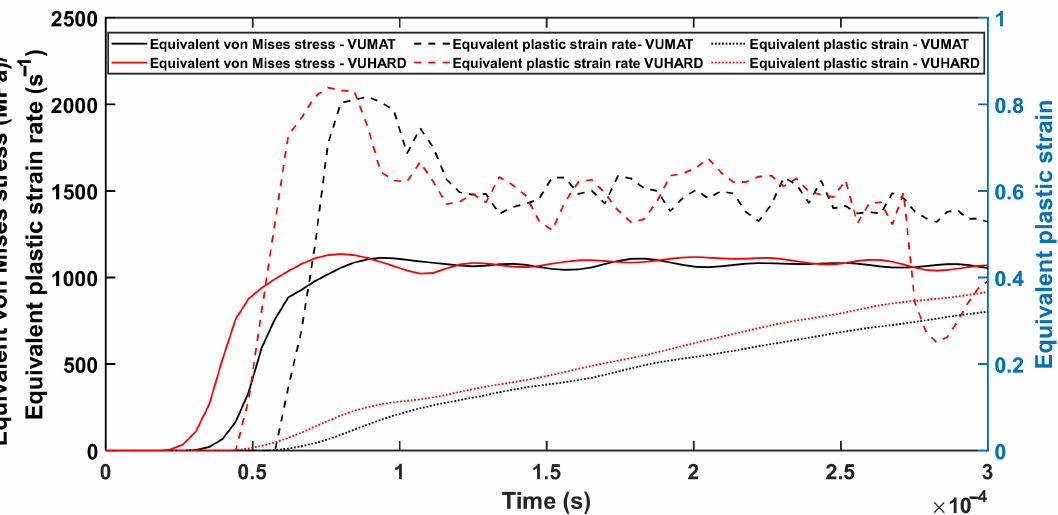
Figure 7. The equivalent von Mises stress, plastic strain and plastic strain rate against time generated during the simulation of the SHPB test using the VUMAT and VUHARD subroutines at an imposed striker velocity of 15 m/s and at a temperature of 25 ◦